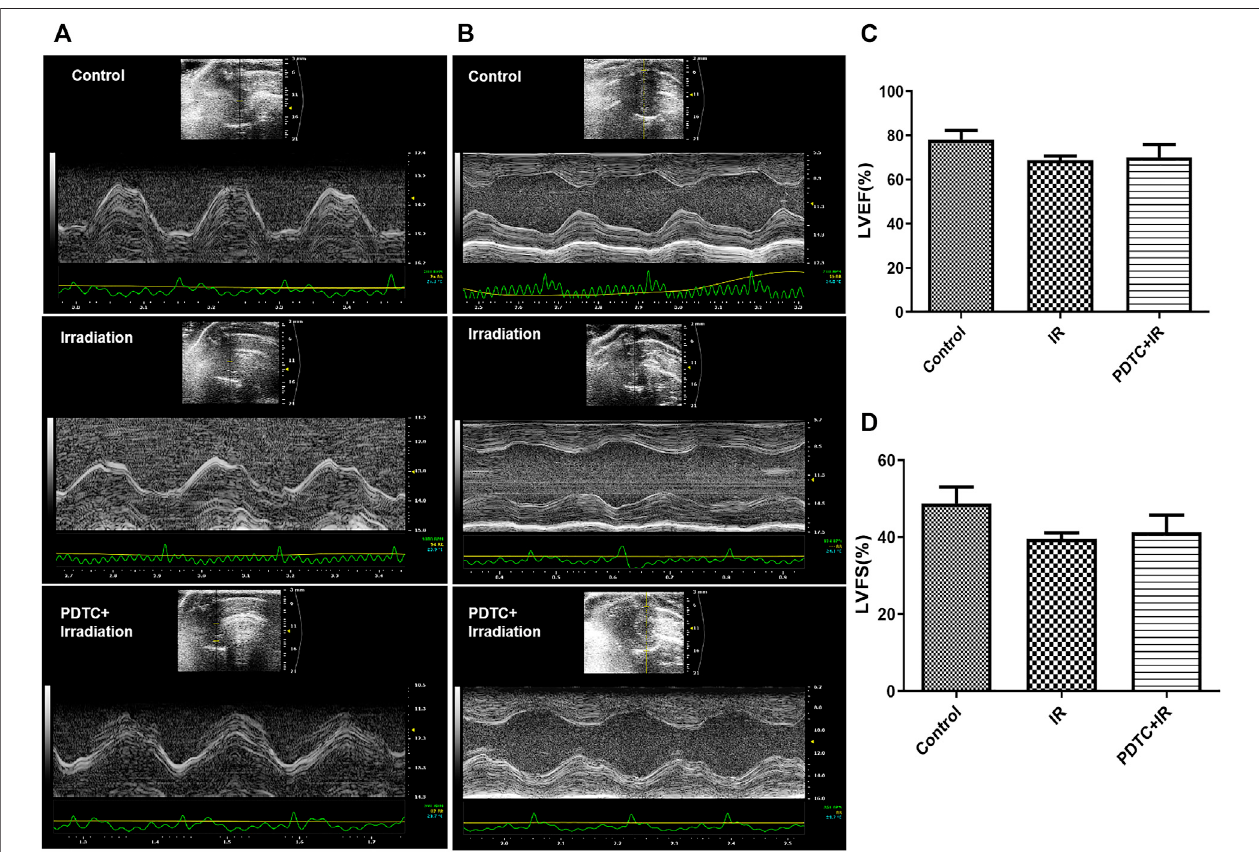
FIGURE2 | Electrocardiographs of theshort axis view in M-mode in rat hearts. (A) Interventricular septum image. (B) Para-sternalshort axis view. (C) LVEF of rats from each group. (D) LVFS of rats from each group.